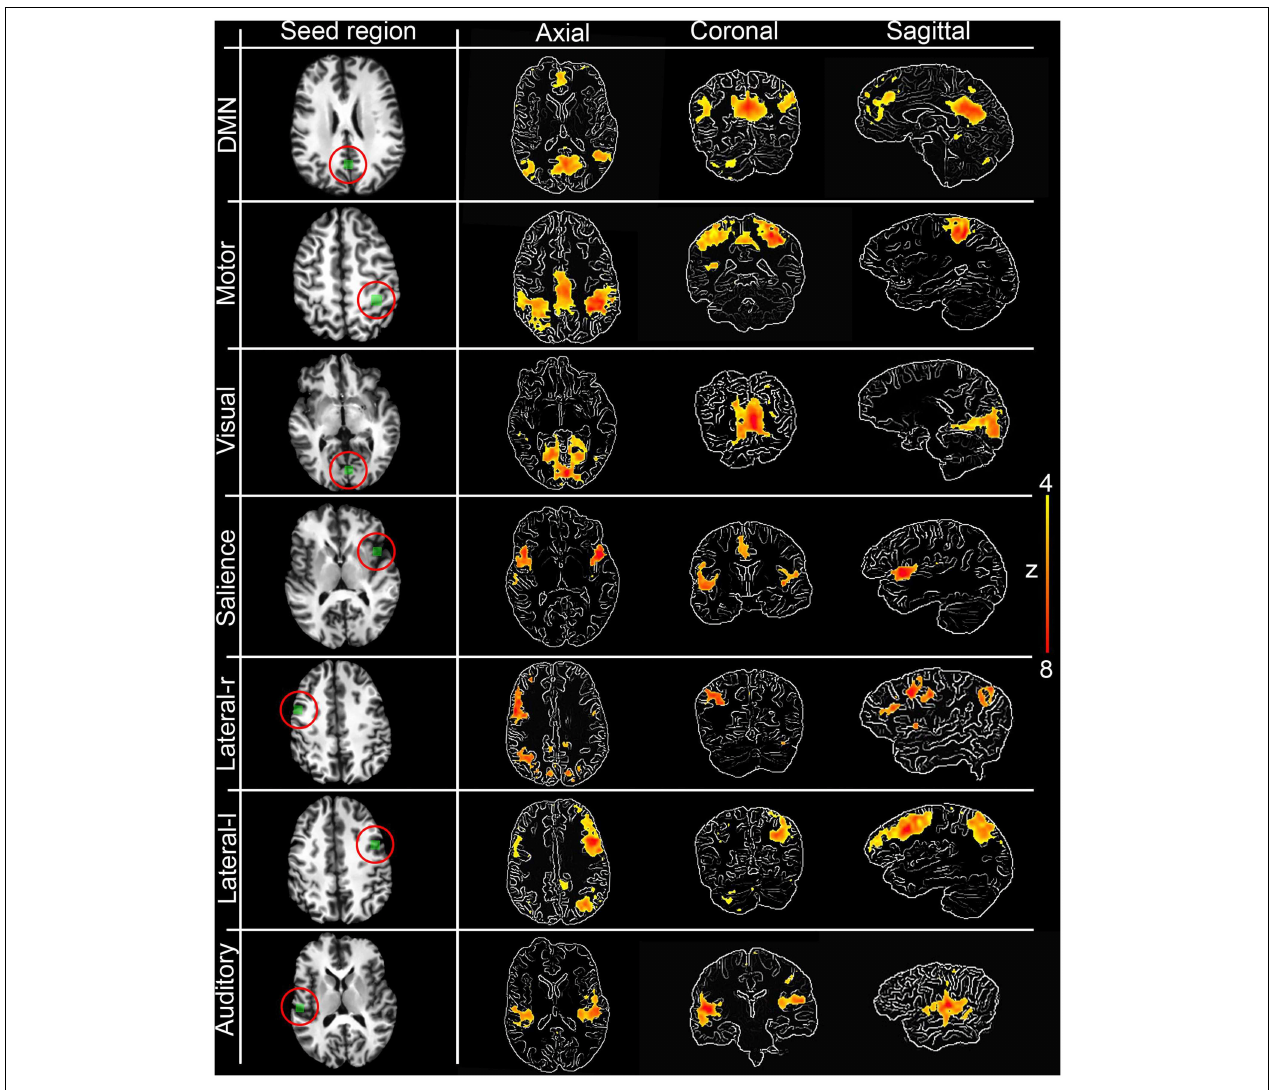
FIGURE 3 | Interactively generated resting state networks ( z > 4 . 0 ) from a single subject used for comparison. The 3D maps were generated by interactively placing a seed-ROI in the circled (red) anatomical regions. DMN: PCC, Motor network: primary somatosensory cortex, Visual network: primary visual cortex,